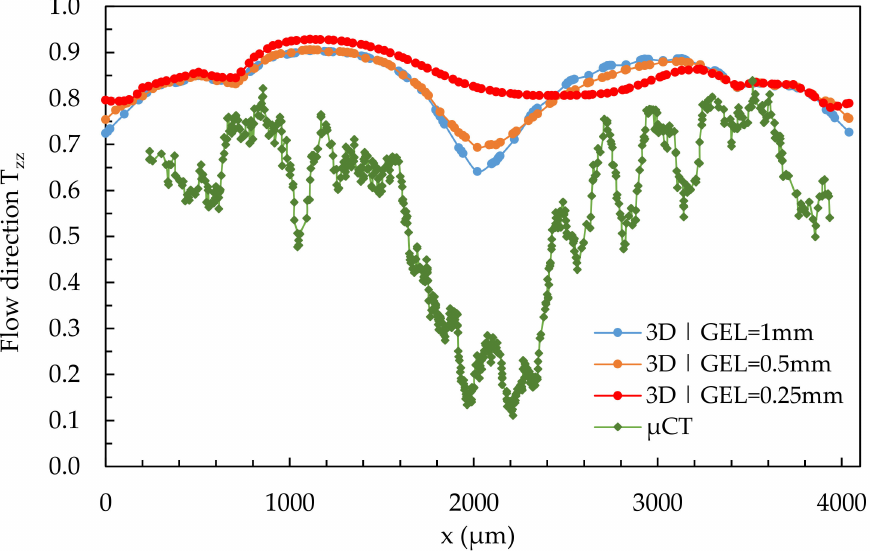
Figure 11. Quantitative results of fiber orientation in T zz -direction over the cross-section characterized by µ CT and predicted by the 3D mesh in region 2 under variation of the GEL at location 2.1. It can be seen that the 3D mesh with a global edge length of 1 mm reproduces the shell-core layer effect best, which contradicts the theory of finite element methods [49]. The core layer becomes smaller, and the fibers are increasingly present in the T zz -direction as